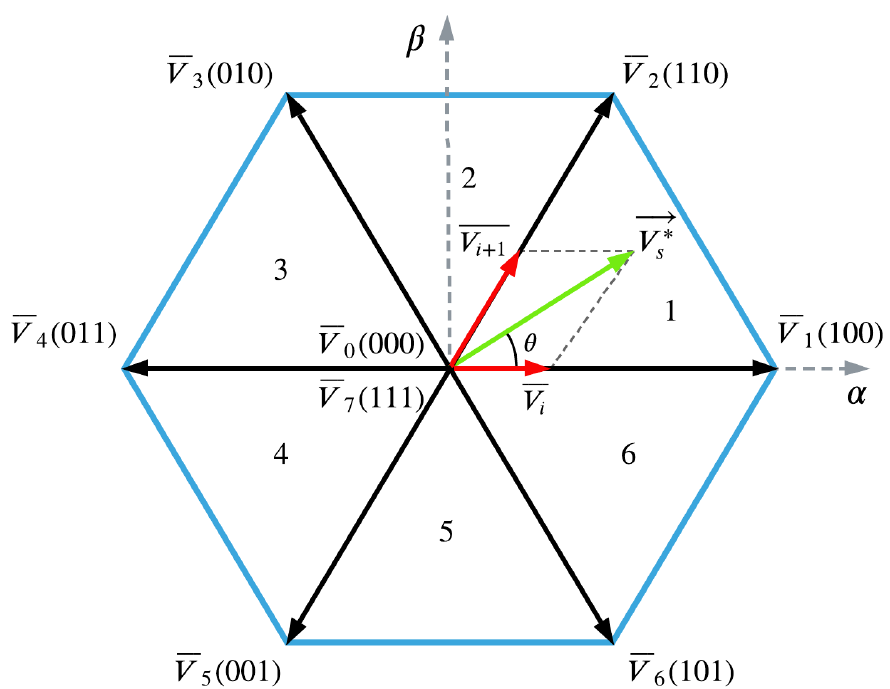
Figure 15. Hexagon of the converter output voltage spatial